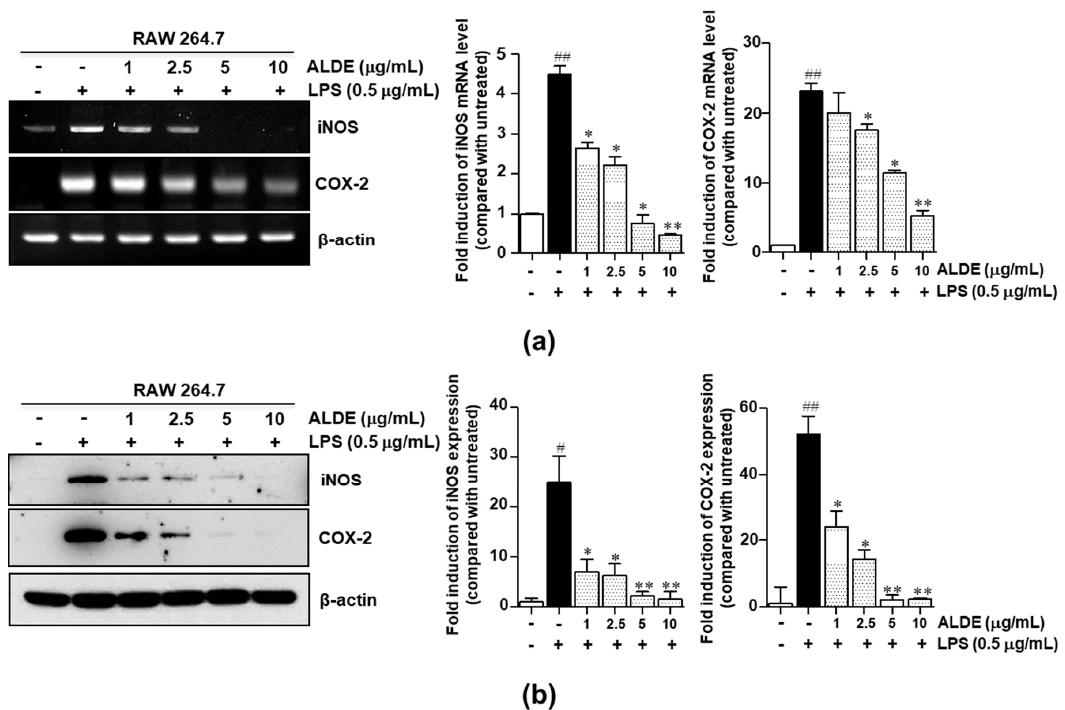
Figure 3. Effects of ALDE on the expression of iNOS and COX-2. RAW 264.7 cells were treated simultaneously with LPS and ALDE (1, 2.5, 5, and 10 µ g / mL). ( a ) Following stimulation for 6 h, total RNA was extracted and reverse transcribed to cDNA. mRNA expression of iNOS and COX-2 was analyzed by RT-PCR. ( b ) After stimulation for 24 h, the total protein was extracted. The protein expression of iNOS and COX-2 was detected by Western blotting. The protein β -actin was used as a loading control for both RT-PCR and Western blotting. The relative density of the mRNA or protein expression was normalized to that of β -actin and is presented in quantitative graphs. The data presented are the mean ± SEM of three independent experiments. Differences between groups were analyzed using the Mann–Whitney U test. # p < 0.05, ## p < 0.01 vs. LPS-untreated control groups; ∗ p < 0.05, ∗∗ p < 0.01 vs. LPS-treated groups. COX-2: Cyclooxygenase-2; iNOS: Inducible nitric oxide